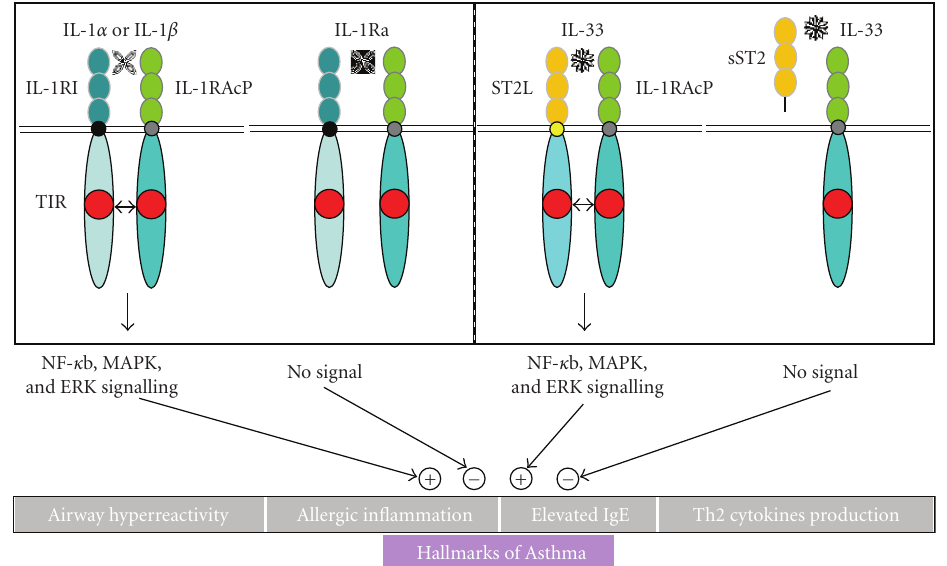
Figure 1: IL-1RI—IL-1 and T1/ST2—IL-33 pathways involved in allergic inflammation in asthma. “+” or “ − ” denote enhanced/activated or attenuated/suppressed e ff ects of modulating signaling pathways, respectively. IL-1RI, IL-1 receptor type I; IL-1RAcP, IL-1 receptor accessory protein; IL-1Ra, IL-1 receptor antagonist; TIR, Toll/IL-1 receptor domains; sST2, soluble ST2; ST2L, trans-membrane ST2; NF- κ B, nuclear factor- κ B; MAPK, mitogen-activated protein kinase; ERK, extracellular signalregulated kinase. Modified from [13, 21, 29, 30].